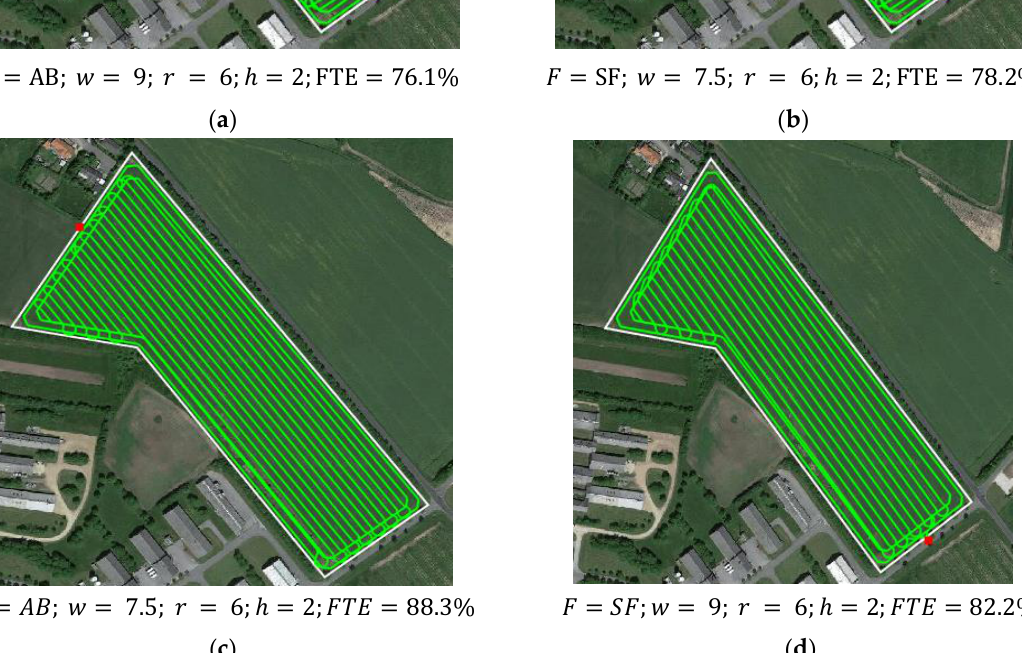
Figure 14. Demonstration of generated continuous paths with FTE on two selected fields (F: pattern; w: width; r: radius; h: